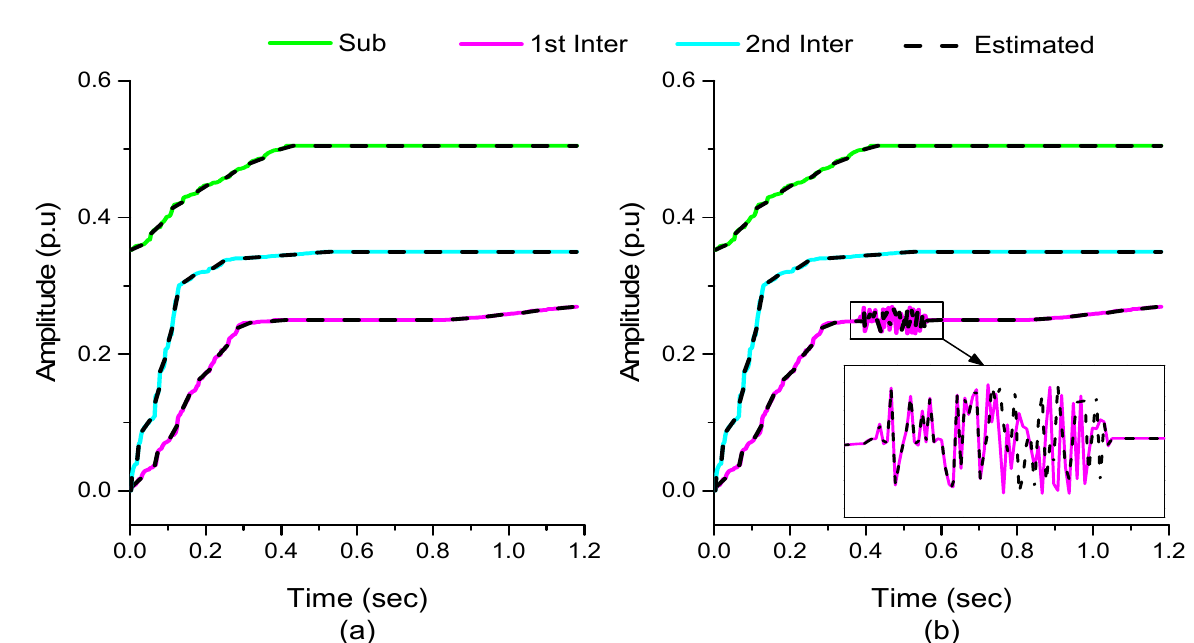
Figure 18. Estimated harmonic amplitude ( a ) steady state condition and ( b ) transient in 1st inter harmonic.